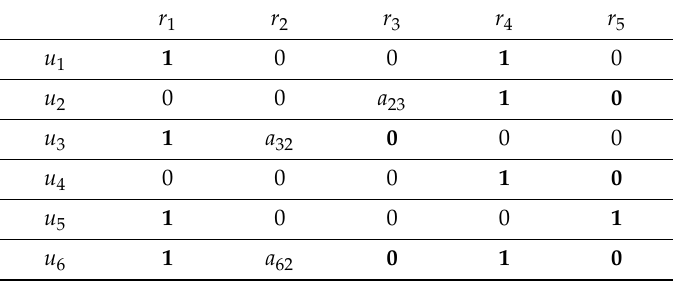
Table 14. Assignments in step 3.